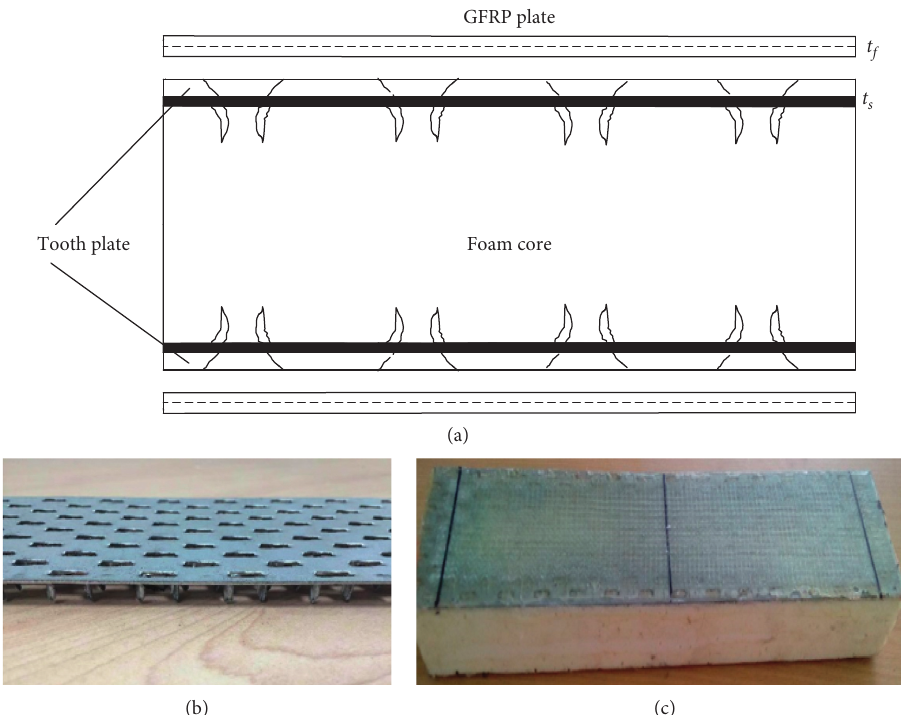
Figure 1: (a) Schematic illustration of TFS specimen; (b) photo of tooth plate; (c) photo of TFS specimen. Table 1: Mechanical properties of GFRP and tooth plate. Type